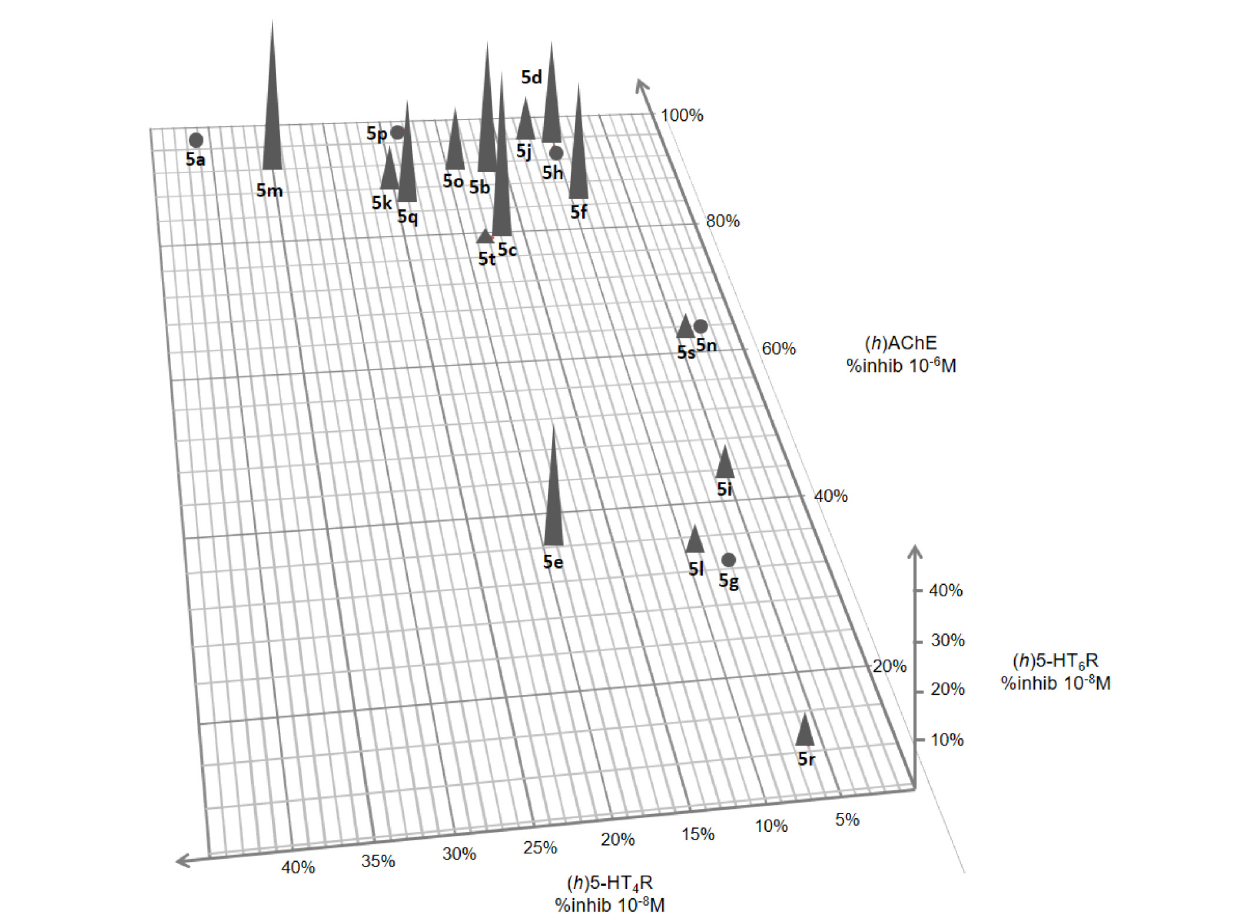
FIGURE 3 | 3D representation of ( h )5-HT 6 R and ( h )5-HT 4 R affinity and ( h )AChE inhibitory activity for compounds 5a–t .